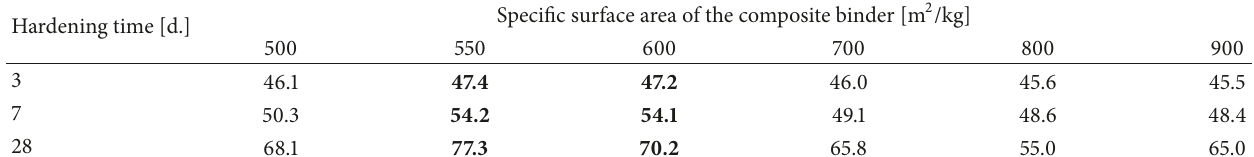
Table 6: Bond between compressive strength [MPa] of the cement stone samples and the specific surface area of the composite binder [4]. Hardening time [d.]